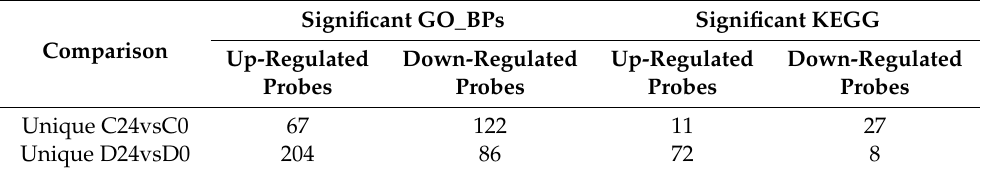
Table 2. Number of significant Gene Ontology biological processes (GO_BPs) and KEGG pathways enriched in the unique up- and down-regulated probes (FDR < 0.05) in both C24vsC0 and D24vsD0 comparisons. The list of the significant terms can be found in Table S4 (sheet tabs C–F).